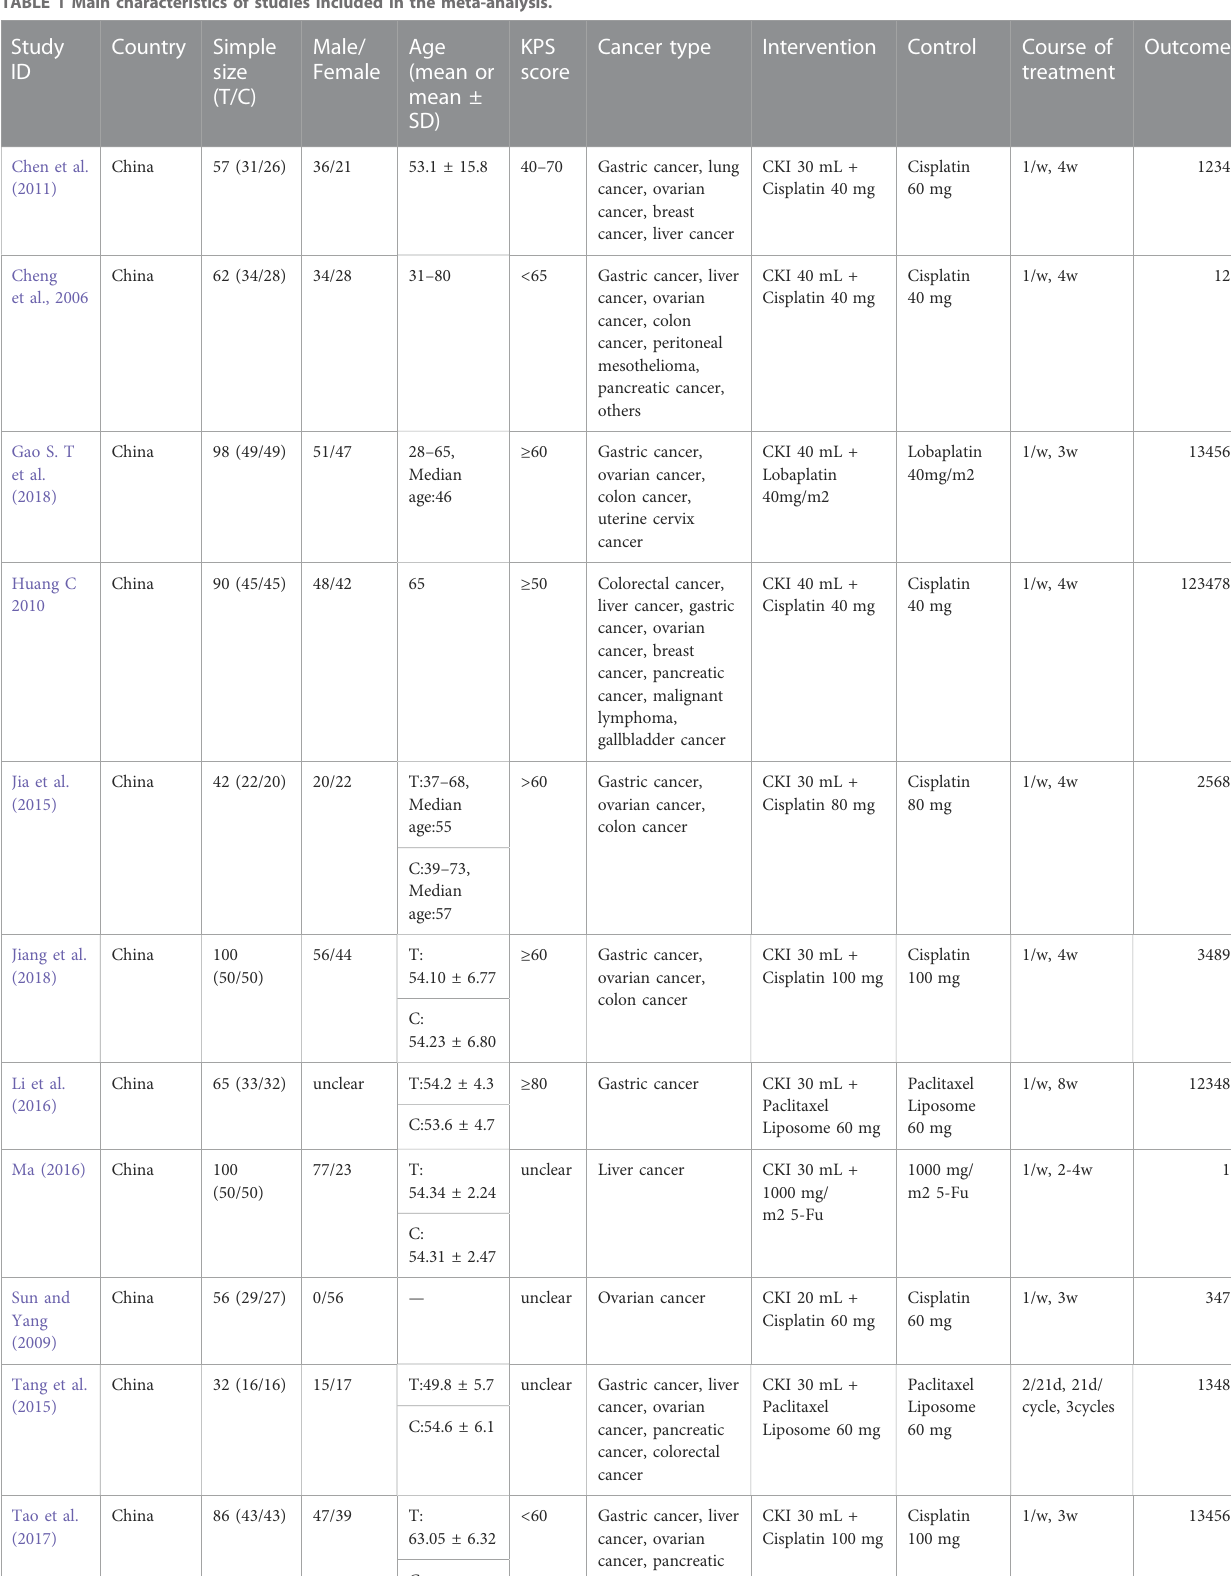
TABLE 1 Main characteristics of studies included in the